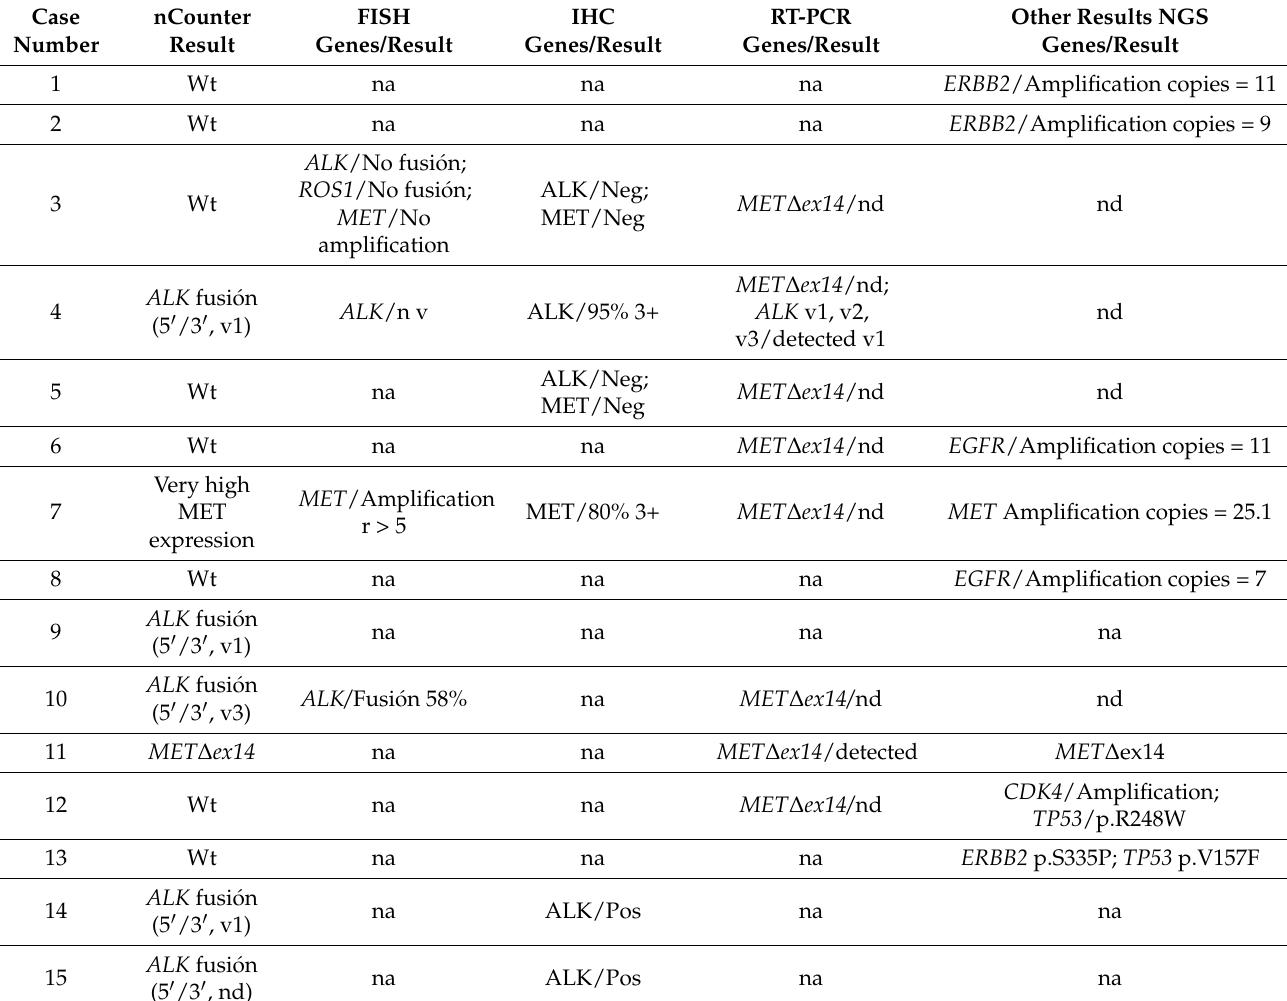
Table 4. Genotying results of the cytological samples.